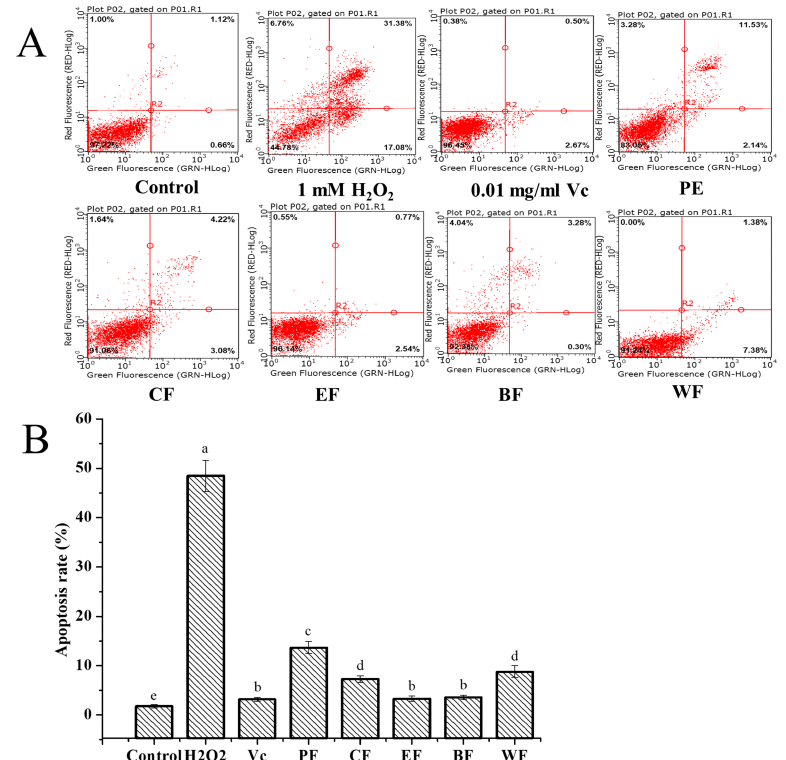
Figure 5. Effect of PF, CF, EF, BF, and WF from V. dunalianum on H 2 O 2 -induced apoptosis in HepG2 cells. ( A ) Flow cytometry analysis; ( B ) the apoptotic cell percentage of different groups. Means (bar values) differ significantly ( p < 0.05) for different letters. PF, CF, EF, BF, and WF denoted petroleum ether fraction, chloroform fraction, ethyl acetate fraction, n -butanol fraction, and water fraction.